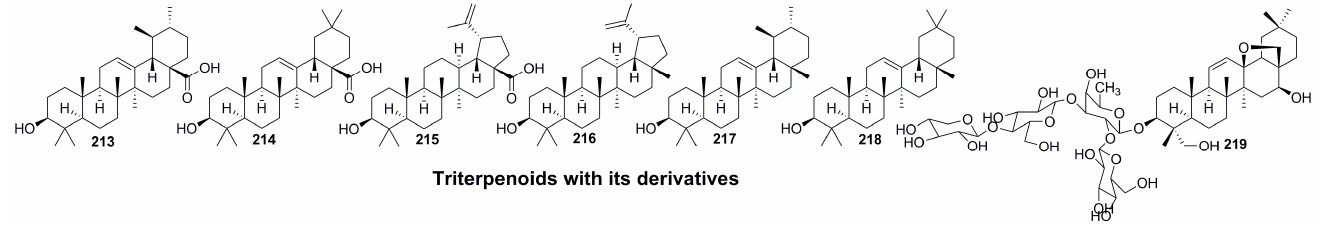
Figure 4. Chemical structures of terpenoids. Table 4. Flavonoids and their glycosides of Pimpinella